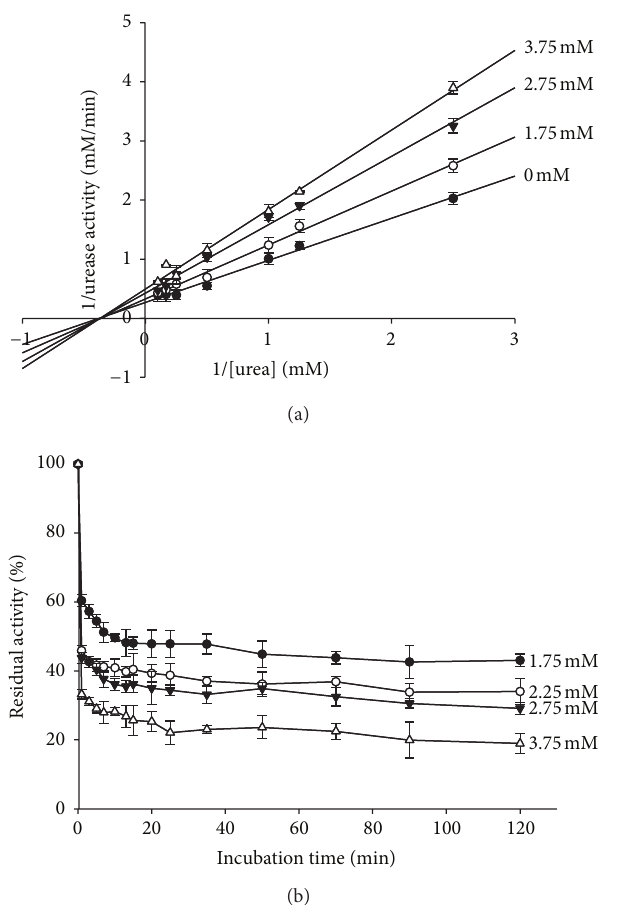
Figure 3: (a) Lineweaver-Burk plot of the reciprocal of urease activity versus reciprocal of substrate concentration in the absence ( e ) and presence of 3.75 mM ( △ ), 2.75 mM ( 󳶃 ), and 1.75 mM ( I ) of BA. (b) Dependence of residual activity versus preincubation time with BA. Concentration of BA (mM) is numerically given. Each value represents the mean ± SD from three independent experiments.